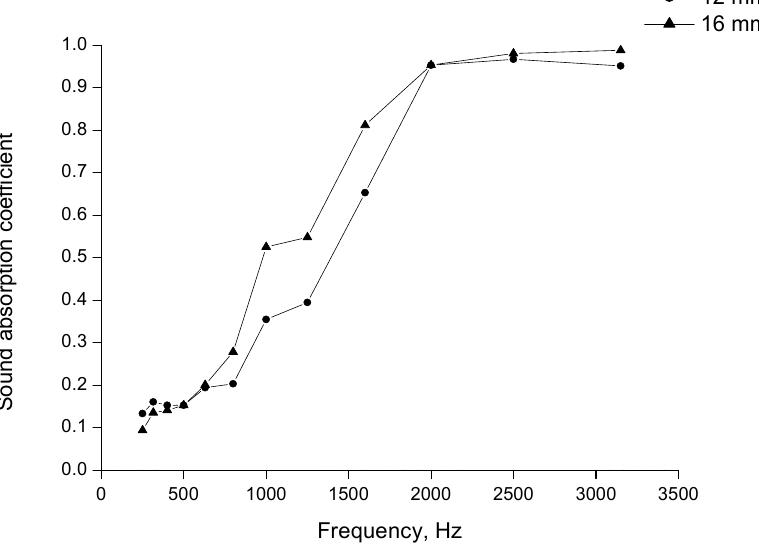
Figure 9. Sound absorption coefficient in normal incident for tufted fabric made from core yarn. The values of the Noise Reduction Coefficient (NRC) calculated for all the investi- gated samples are presented in Figure 10. The NRC was relatively low for the thinner felt. It was much higher for the thicker felt and reached the level determined for tufted fabrics. For all the tufted fabrics made both of the ring spun and the core rug yarns, the NRC value was between 0.4 and 0.43. For both types of yarn, the greater the pile height, the slightly higher the NRC value.